Question: Generate an informative caption for the figure above.
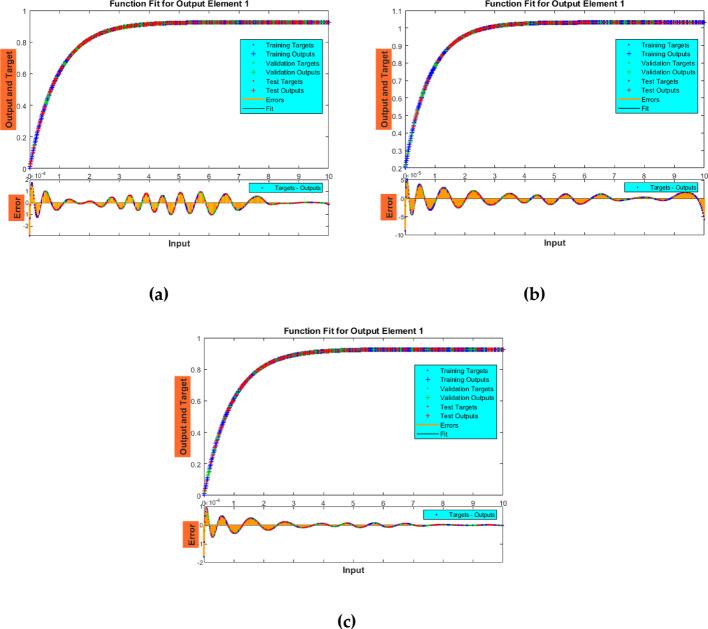
Answer: a-c Curve fitting for ANN design (Scenarios 1–3)